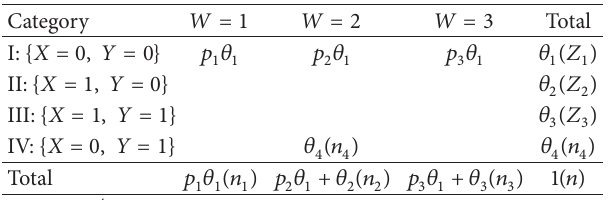
Table 3: Cell probabilities, observed and unobservable counts for the main questionnaire.